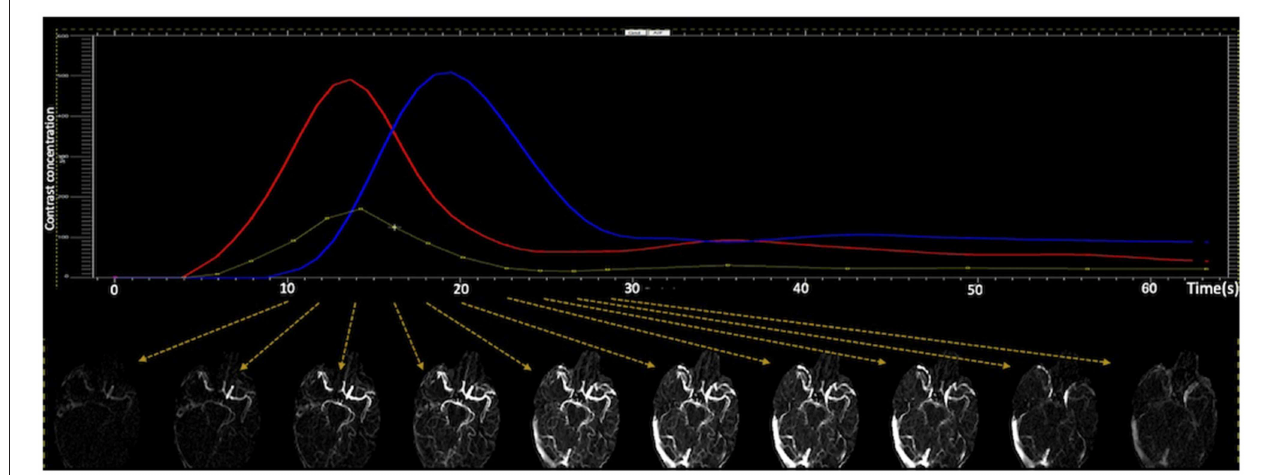
FIGURE 1 | Generating dynamic CTA images. Ten continues CTA images were manually selected from CTP source images, which covers early artery phase, peak arterial phase, late arterial/peak venous phase, and late venous/washout phase.